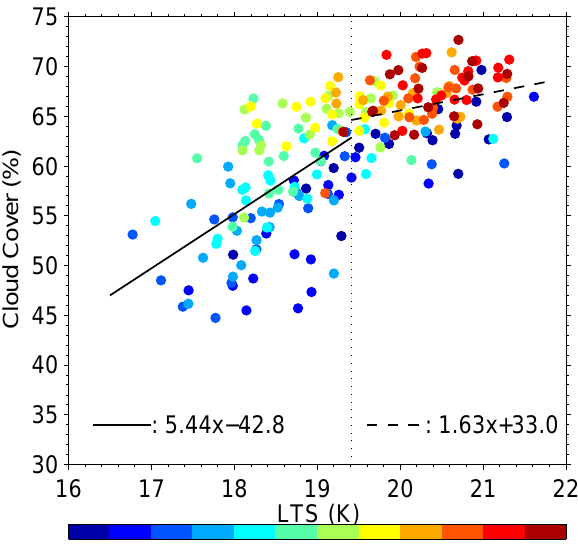
Fig. 4. Scatterplot of the monthly area-averaged (70 ◦ –110 ◦ W, 10 ◦ –30 ◦ S, refer to the box of Fig. 1) LTS versus monthly area- averaged adjusted low cloud amount from 1983 to 2002, color- coded by calendar months. The dotted line denotes the annual mean LTS=19.4K. The solid (dashed) line denotes linear least-square re- gression line when LTS < ( >